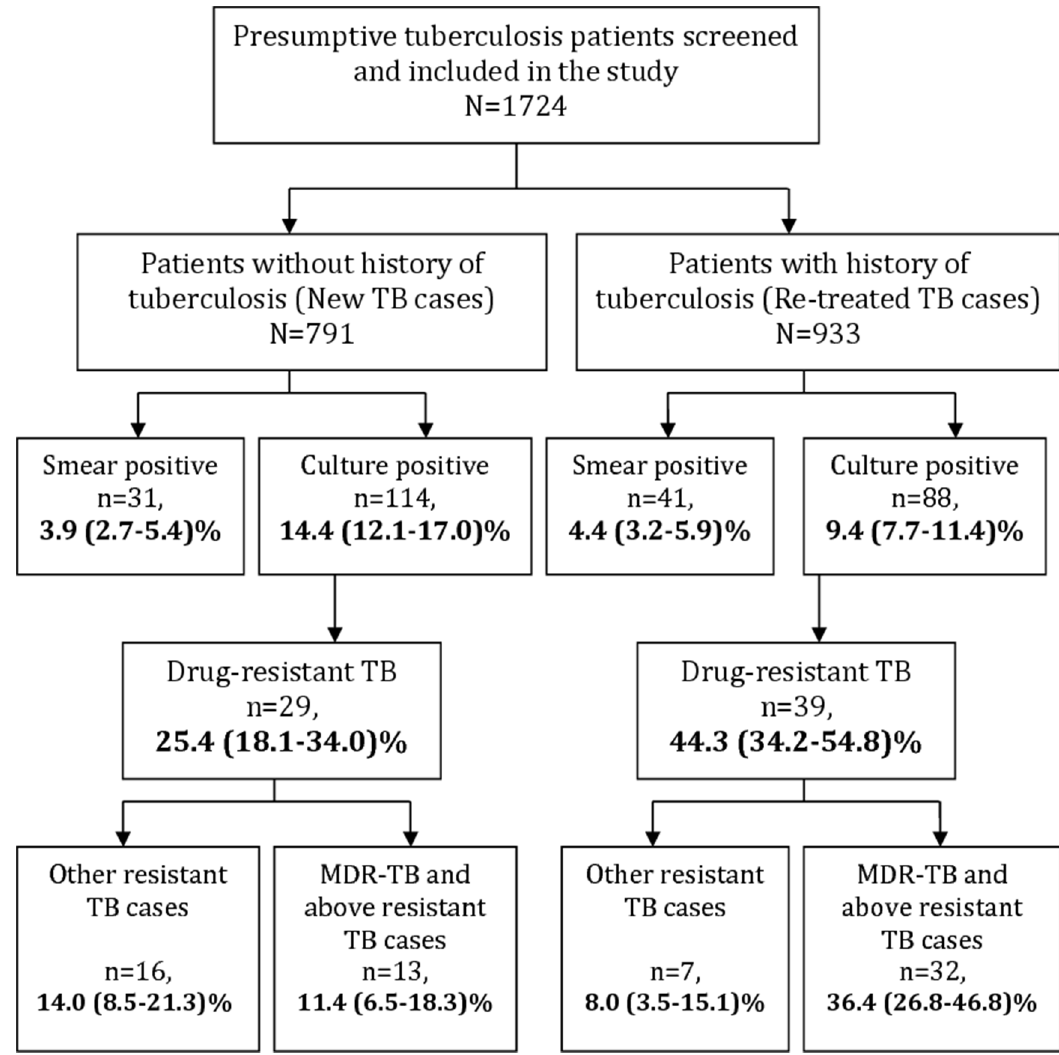
Figure 2. Distribution of Drug-resistant tuberculosis among HIV-infected (new and previously treated) with presumptive tuberculosis patients, Mumbai, India.